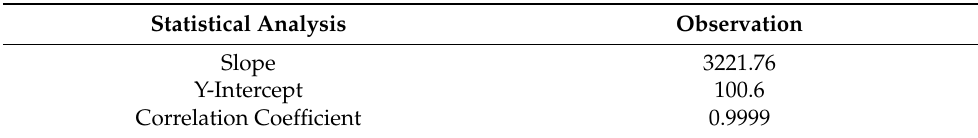
Table 3. Linearity of Si ( λ =